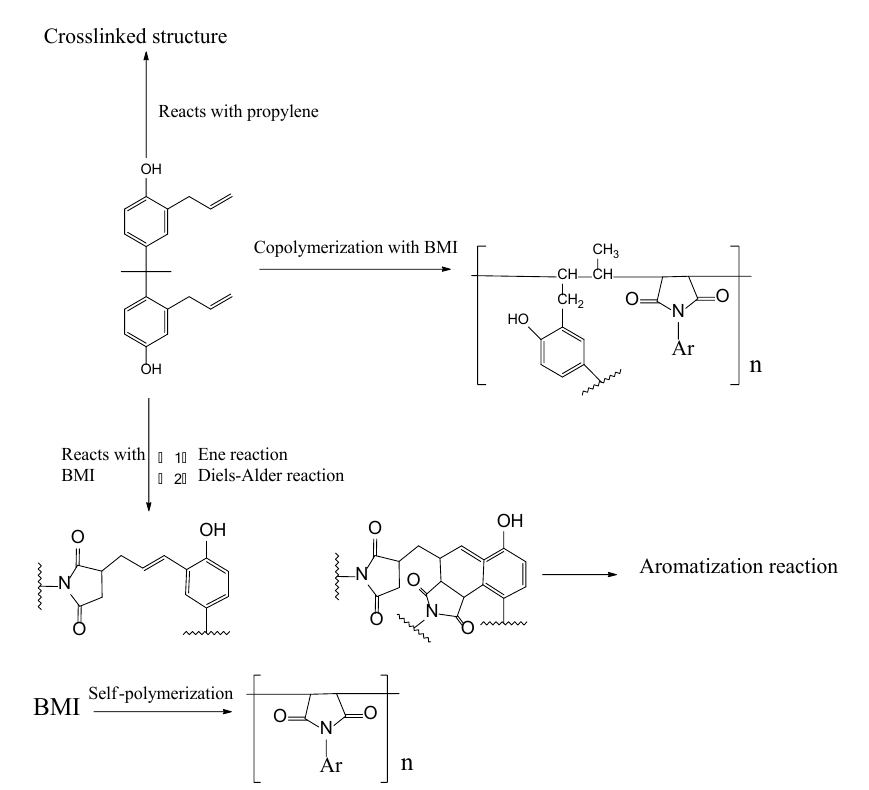
Figure 4. The reactions of allyl bisphenol A-modified bismaleimide resin [25].